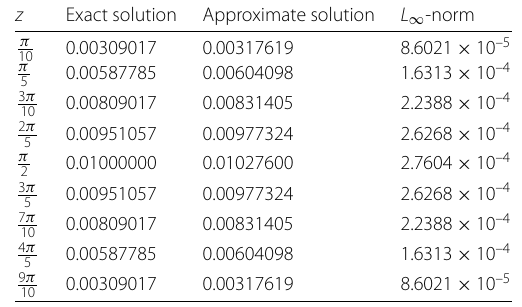
Table 10 Maximum absolute errors ( L ∞ ) for Example 3 at t = 0.1 when α = 0.9, n = 10, (cid:3) t = 0.001, and z ∈ [0, π ]